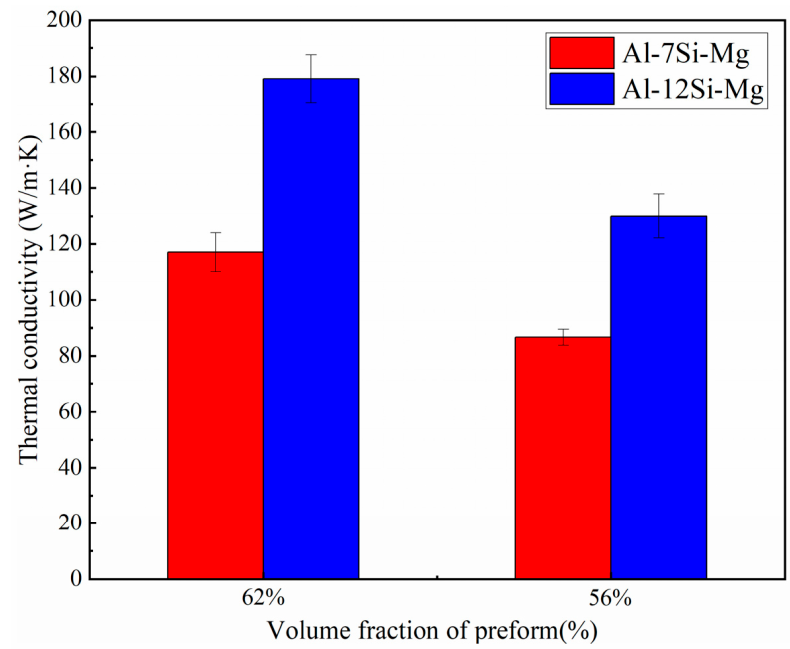
Figure 7. Thermal conductivity of composites infiltrated with Al-7Si-Mg and Al-12Si-Mg.